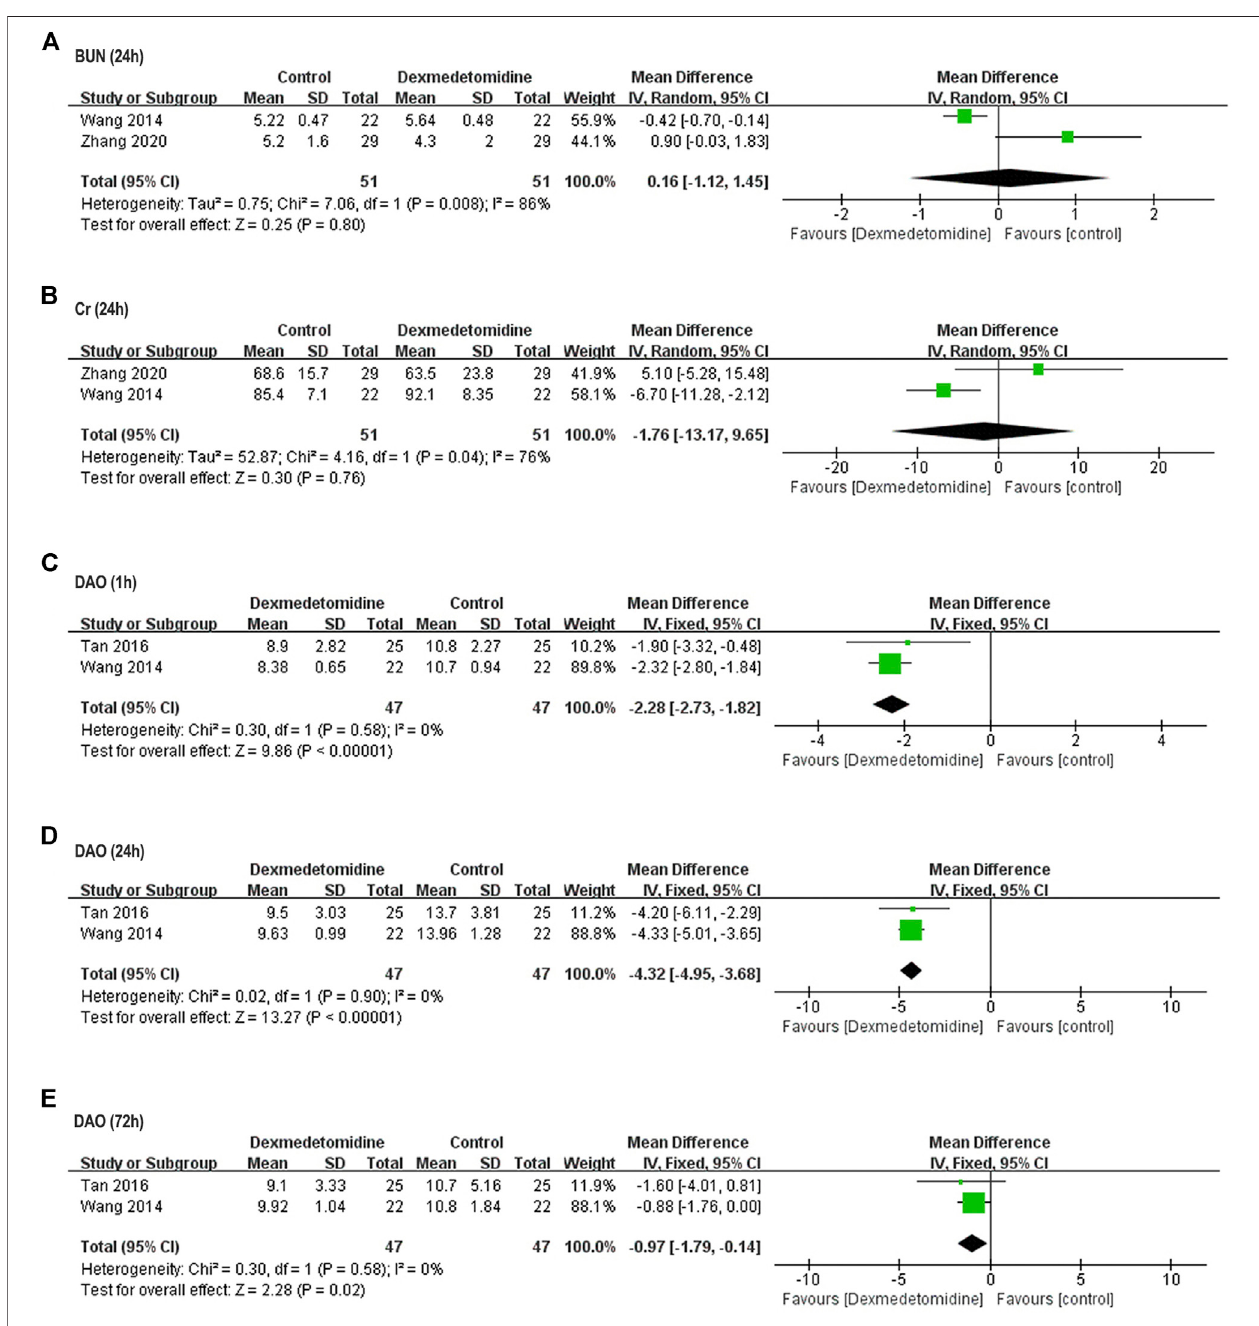
FIGURE5| Forestplots formeta-analyses comparing postoperative renal functionand intestinalinjury. (A) BUN (24 h after surgery); (B) Cr(24 hafter surgery); (C) DAO (1 h after surgery); (D) DAO (24 h after surgery); (E) DAO (72 h after surgery).